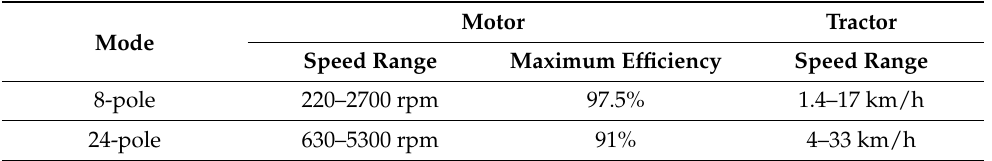
Table 5. Performance parameters of DHPCM-SPMPs. Table 4. Operation parameters of DHPCM-SPMPs and